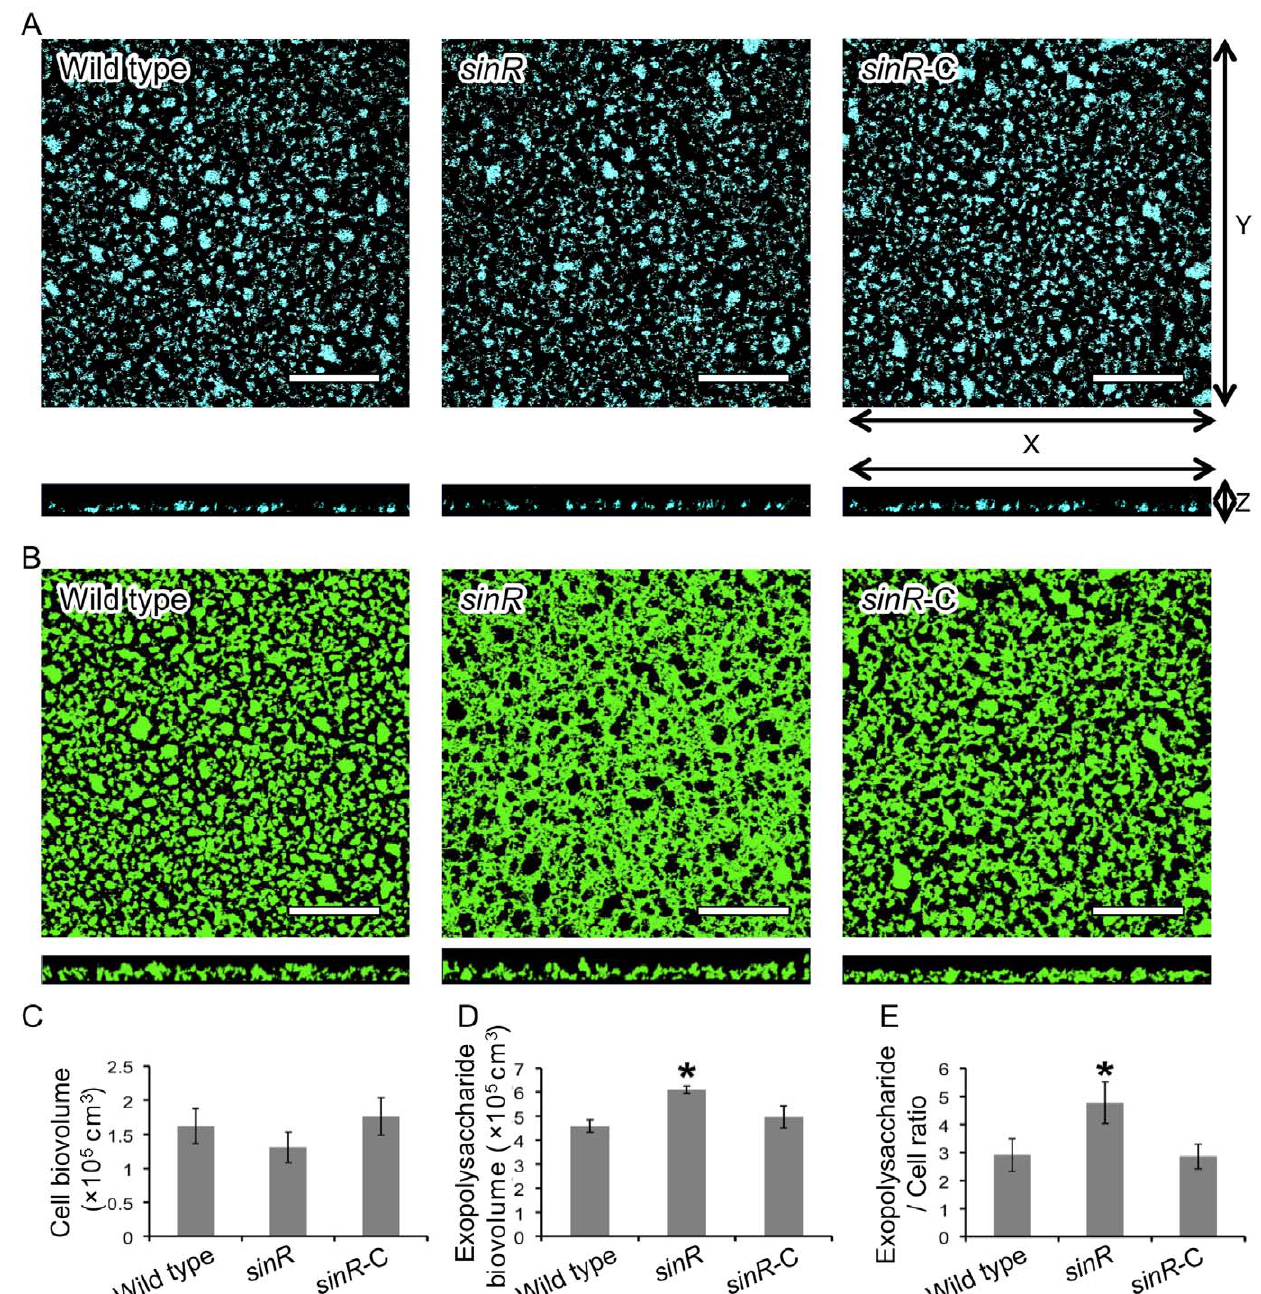
Figure 2. CLSM observation of biofilms formed by P.gingivalis strains. P. gingivalis strains were stained with DAPI (blue) and incubated in PBS for 24 h. After washing, exopolysaccharide was stained with FITC-labeled concanavalin A and wheat germ agglutinin (green). P. gingivalis cells (A) and exopolysaccharides (B) of biofilms that developed on the coverglasses were observed with a CLSM equipped with a 40 6 objective. Scale bars represent 50 m m. Optical sections were obtained along the z-axis at 0.7- m m intervals, and images of the x-y and x-z planes were reconstructed with imaging software as described by Kuboniwa et al . [19]. Fluorescent images were quantified using Imaris software and the average of total cell biovolume per field (C) and that of total exopolysaccharide biovolume per field (D) were calculated. Furthermore, exopolysaccharide levels are expressed as the ratio of exopolysaccharide/cells (FITC/DAPI) fluorescence (E). The experiment was repeated independently three times. Data are presented as average of 8 fields per sample along with the standard errors of the mean. Statistical analysis was performed using a Welch’s t test. * P , 0.001 in comparison with the wild type strain. doi:10.1371/journal.pone.0056017.g002 proteins are those that polymerize into fibers variously known as associated genes during the development of biofilms was elevated pili or fimbriae [20,21]. P. gingivalis produces long (FimA) and short in the early stage but remained unchanged during the later stages (Mfa) fimbriae [19]. In our previous study, expression of fimbriae- [16]. Furthermore, expression of sinR was down-regulated only in